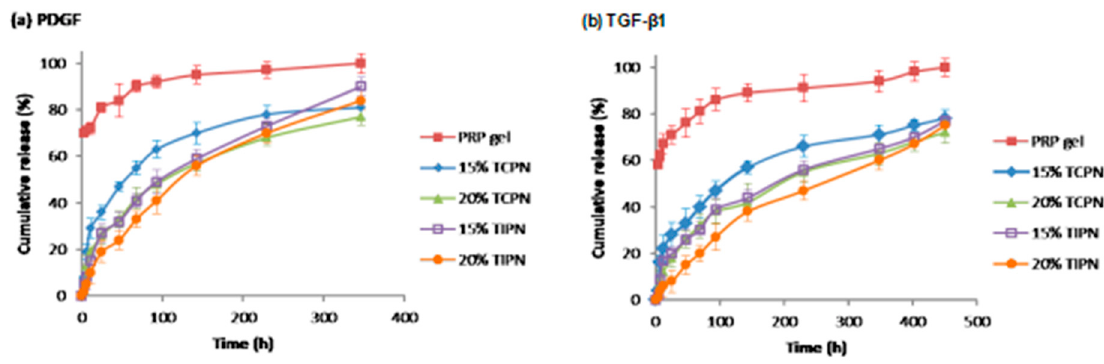
ff erent hydrogel